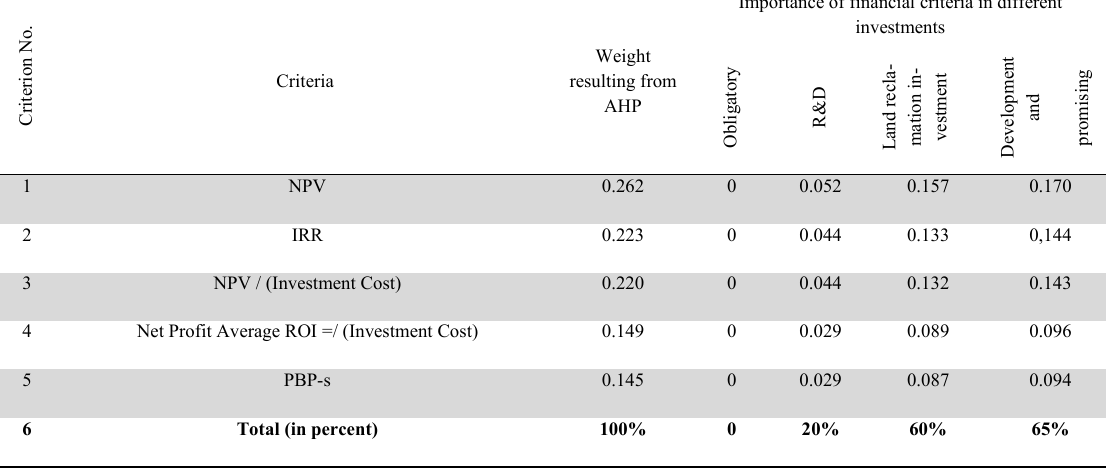
Importance of financial criteria in different investments